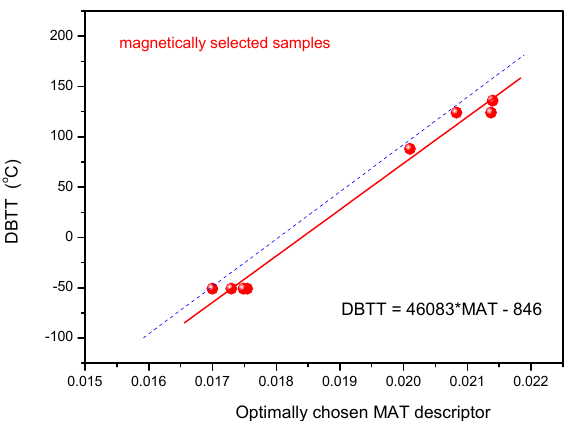
Figure 8. Estimation of the transition temperature from the MAT descriptors, measured on magnetically selected samples (subset). For a better comparison, the linear fit of Figure 7 is also shown as a blue dashed line.